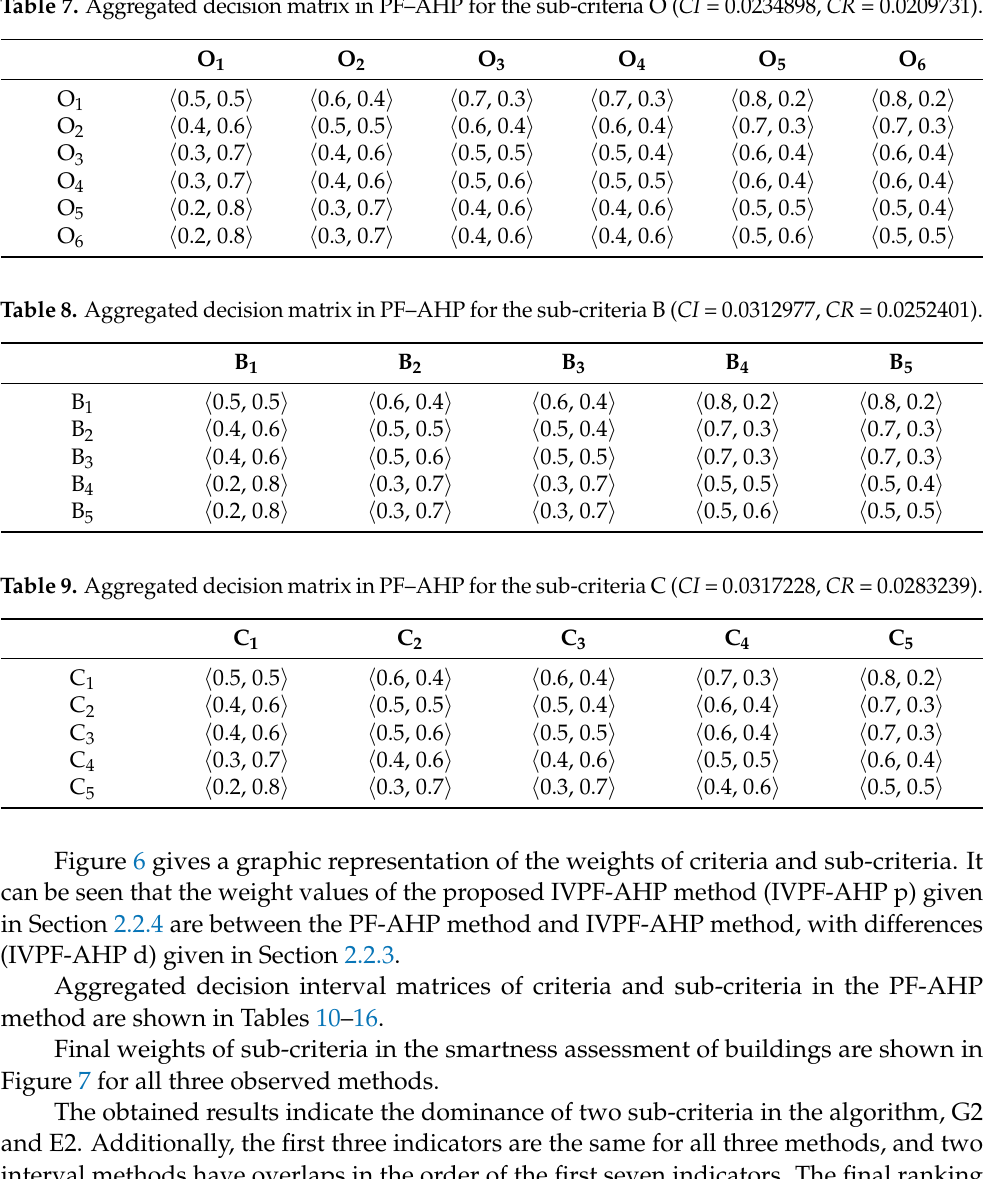
Table 7. Aggregated decision matrix in PF–AHP for the sub-criteria O ( CI = 0.0234898, CR = 0.0209731).